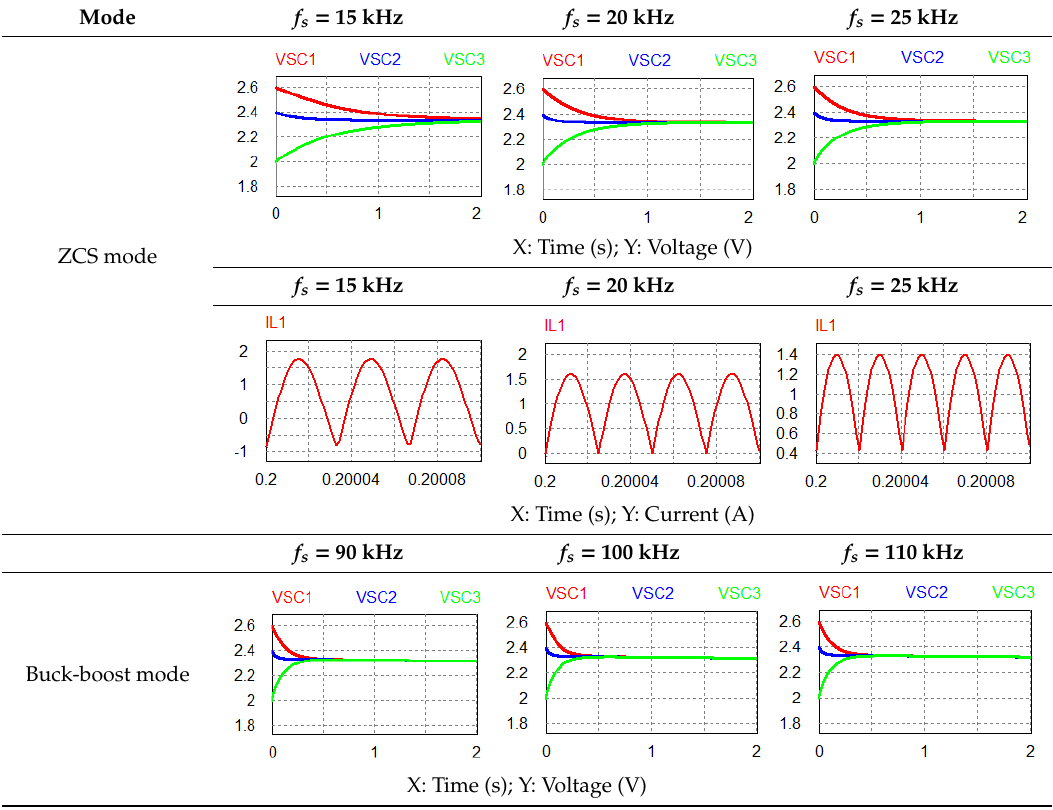
Figure 8. Multi-functional equalizer built in laboratory.